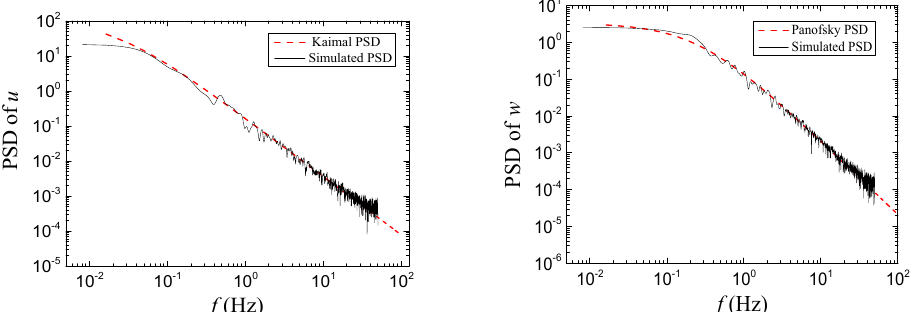
ff erent turbulent components in the simulated wind Figure 17. PSDs of different turbulent components in the simulated wind field. Figure 17. PSDs of di Figure 17. PSDs of different turbulent components in the simulated wind field.